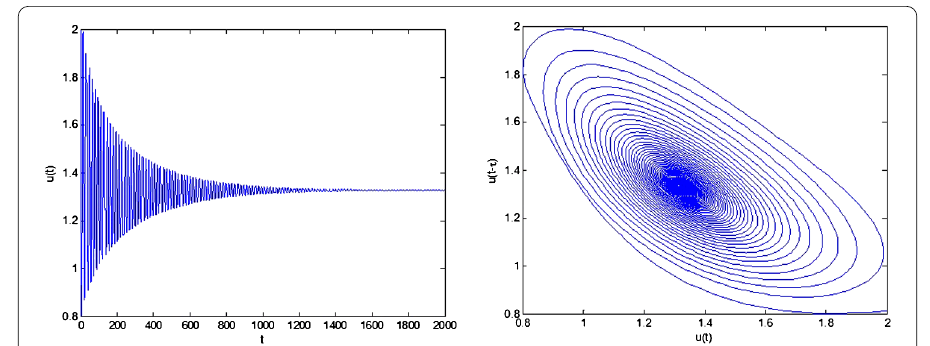
Figure 5 Waveform plot and phase portrait of the controlled fractional-order model (4.2) with α = 0.92, m = 0.2, k p = 0.05, k d = 0.5 and the initial value u 0 = 2. The equilibrium u ∗ is asymptotically stable when υ = 6 < υ c 0 = 6.1794.